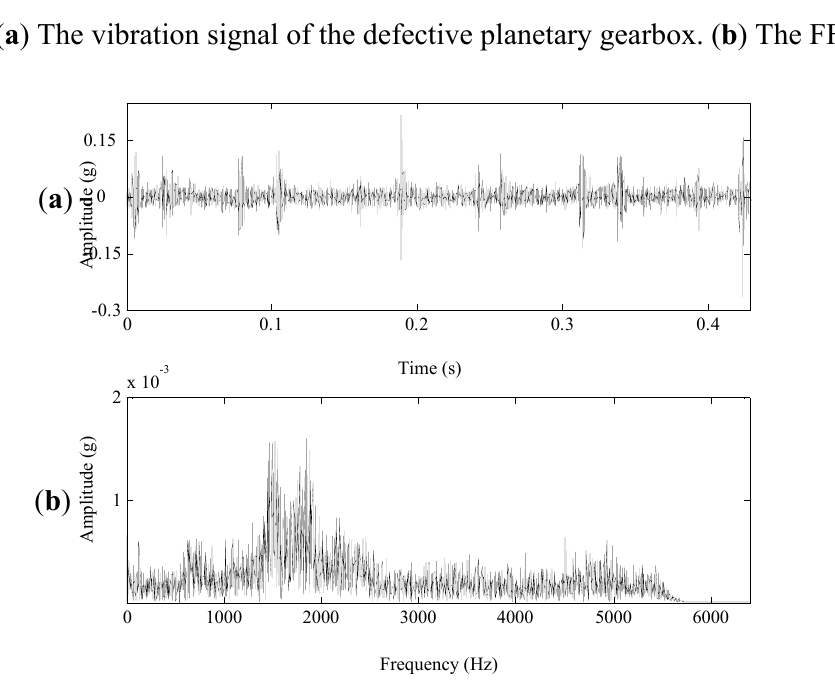
Figure 15. The denoising results of the vibration signal using the proposed